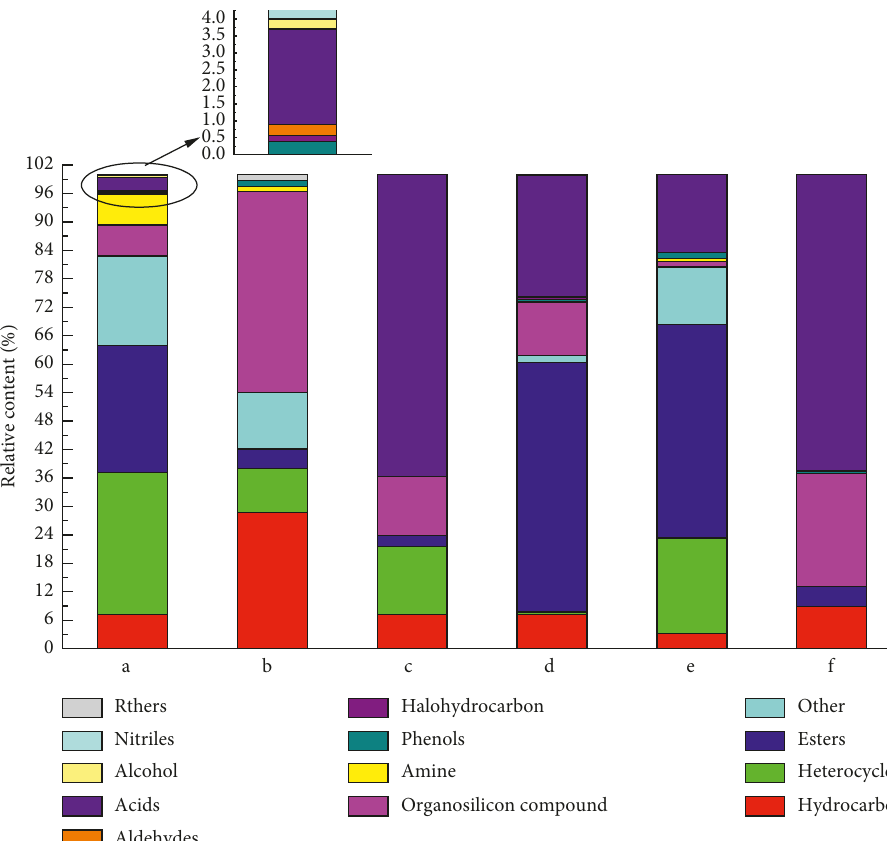
Figure 3: Relative contents of the classes refractory organic compounds in three types of typical pharmaceutical wastewater: (a), (c), and (e) represent the influent of antibiotic wastewater, Chinese traditional medicine wastewater, and chemical synthesis wastewater, respectively; (b), (d), and (f) represent the corresponding